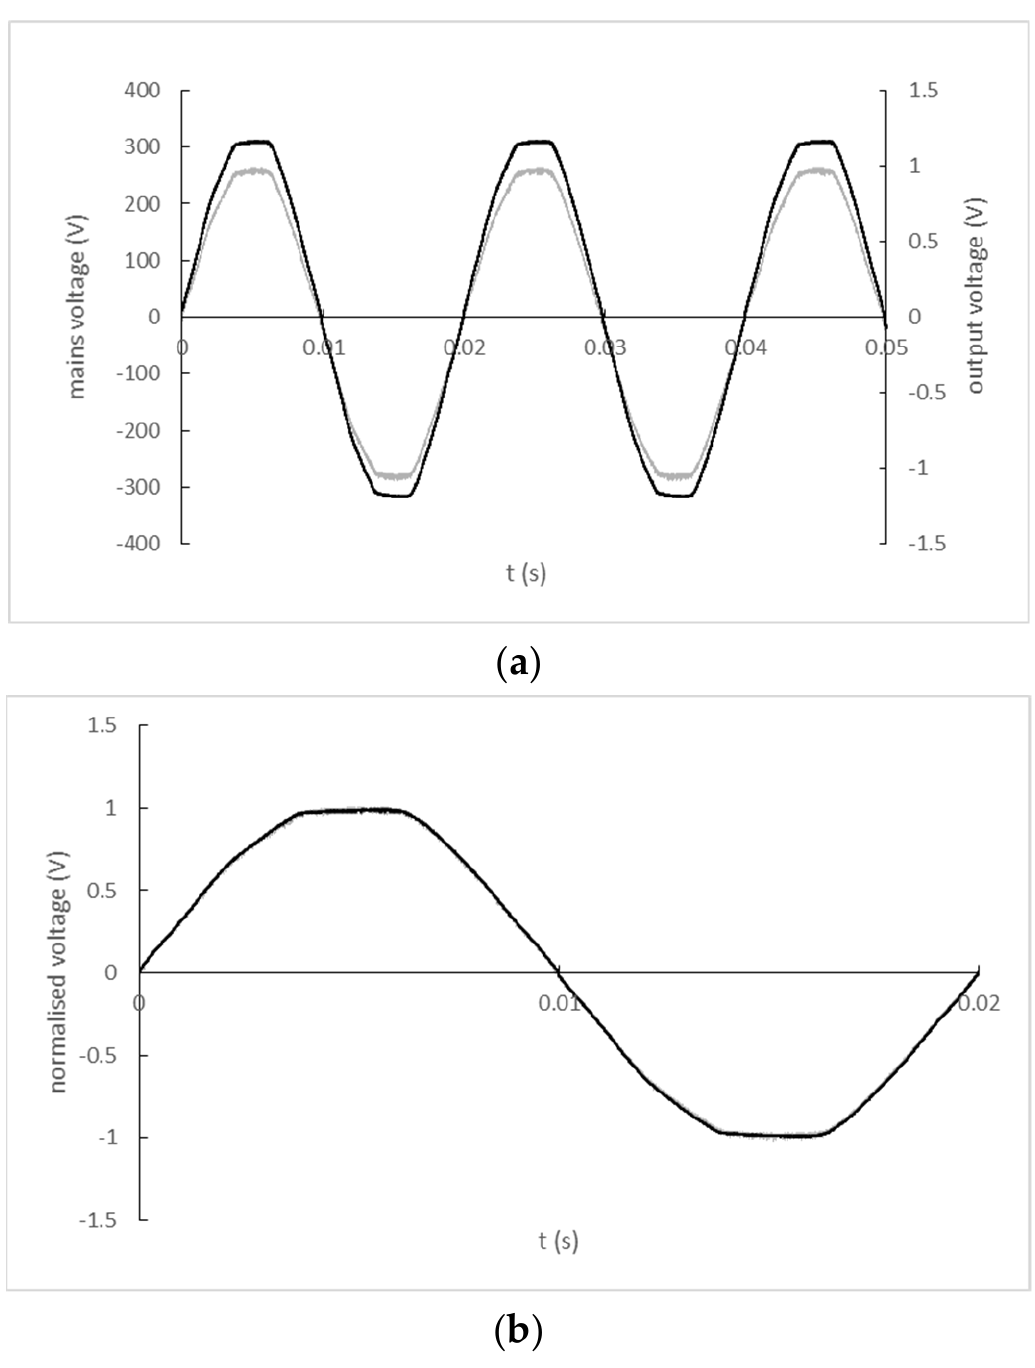
Figure 12. ( a ) The input and output signal record of ZMPT101B current transformer (black line— mains; grey line—output); ( b ) Normalized and zero-crossing time shift-corrected input and output waveforms of ZMPT current transformer (black line—mains; grey line—output).